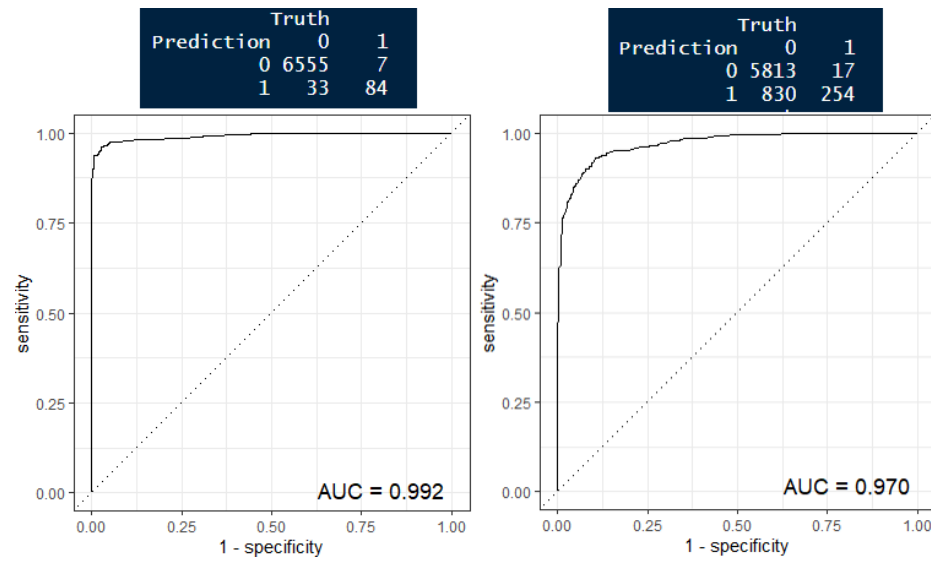
Figure 11. Random forest model fit on original wet- and slab-avalanche datasets using CM, ROC, and AUC metrics.